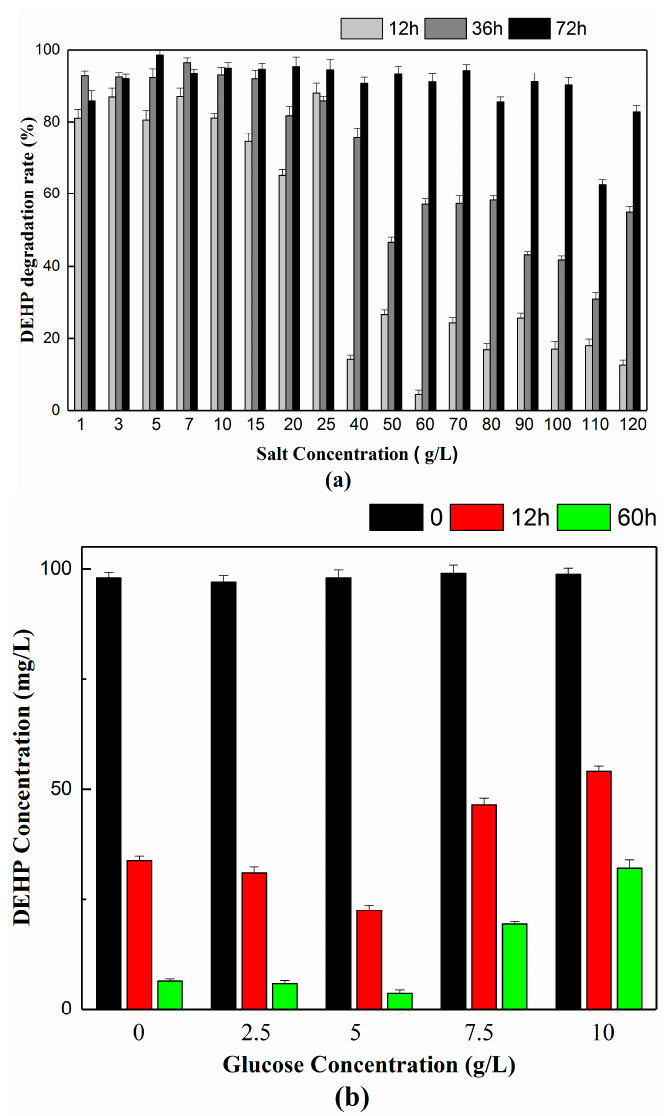
Figure 5. ( a ) Effects of sodium chloride (NaCl) concentration on DEHP degradation. DEHP degradation efficiency by strain YC-YT1 under different NaCl concentrations. ( b ) Effects of glucose concentration on DEHP degradation. DEHP degradation efficiency by strain YC-YT1 under different glucose concentrations. Error bars indicate standard deviations of the means.